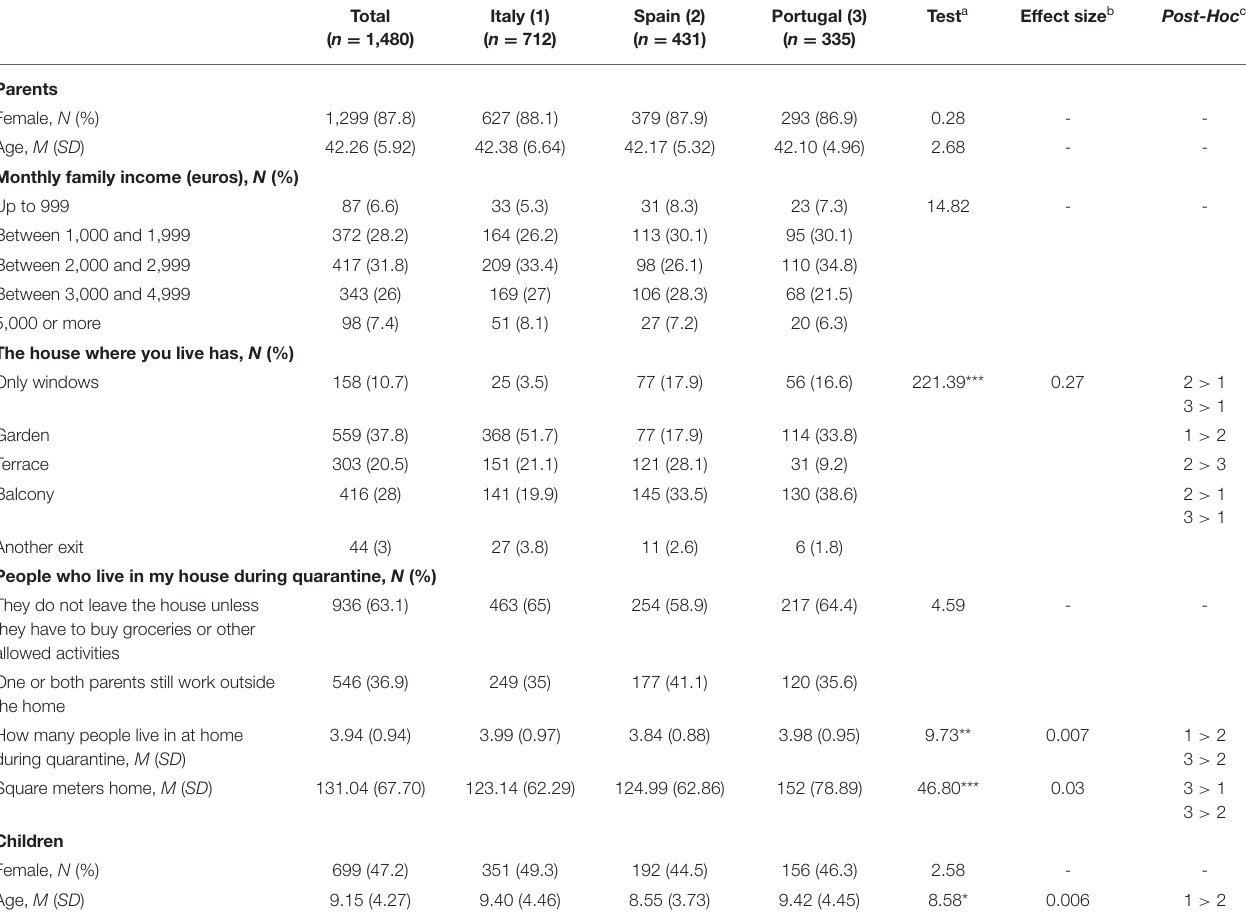
TABLE 1 | Sample characteristics and equivalence by